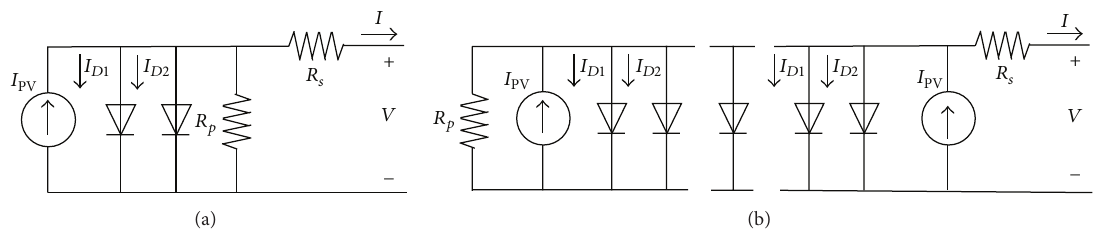
Figure 6: Models of c-Si-based solar cell: (a) two-diode model [14]; (b) multidiode model with vertically aligned p-n